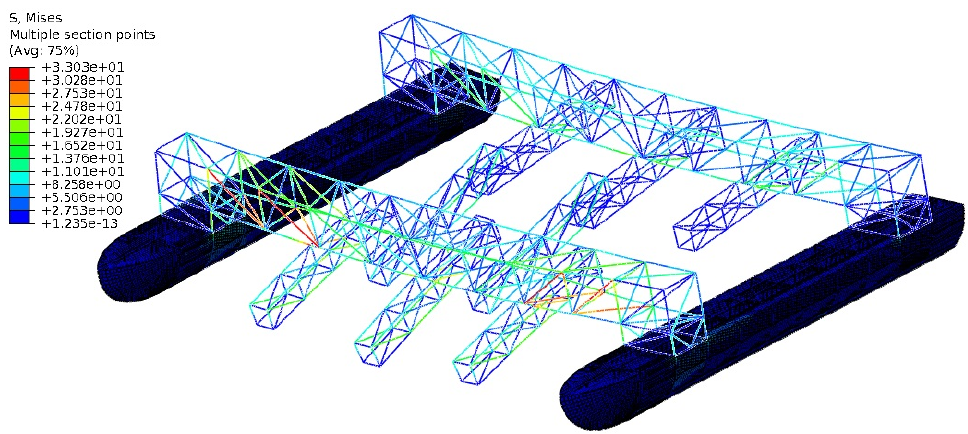
Figure 7. Stress distribution on the FEA